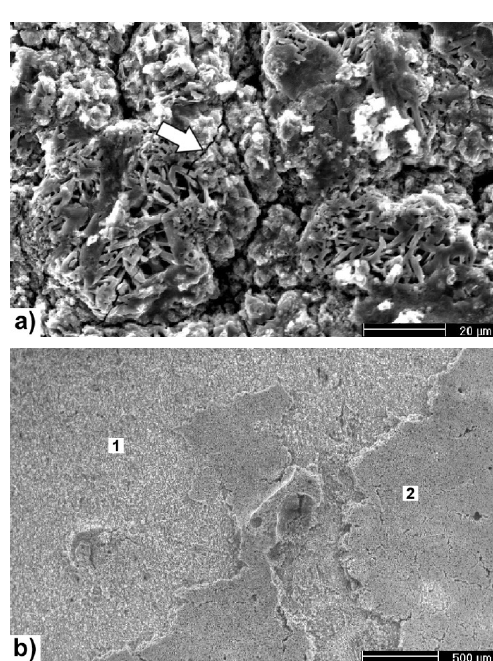
Figure 4. Secondary electron images showing the surfaces of unexposed aluminized specimens. a) P91. A small crack is indicated with an arrow. b) HCM12A. 1) Dense coating layer. 2) Porous surface layer on top of the dense